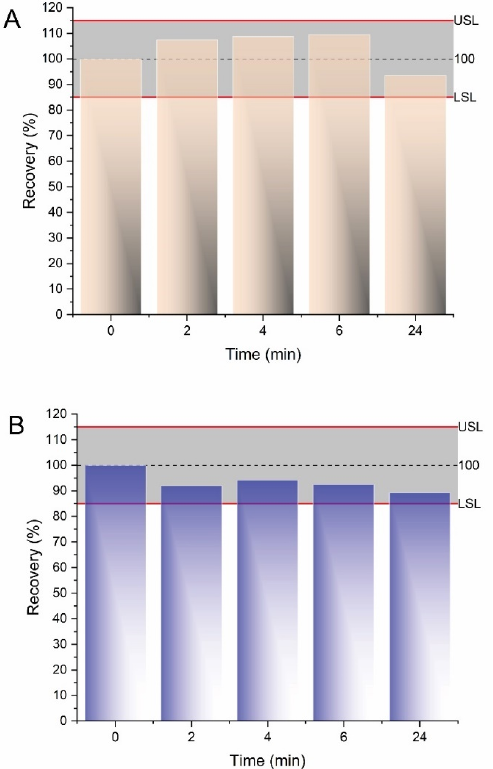
Figure 7. Stability data of ( A ) Colistin A and ( B ) Colistin B at ambient temperature in unprocessed urine samples. The lower specification limit (LSP) and the upper specification limit (USP) of the percentage recovery were set at 85% and 115%, respectively.